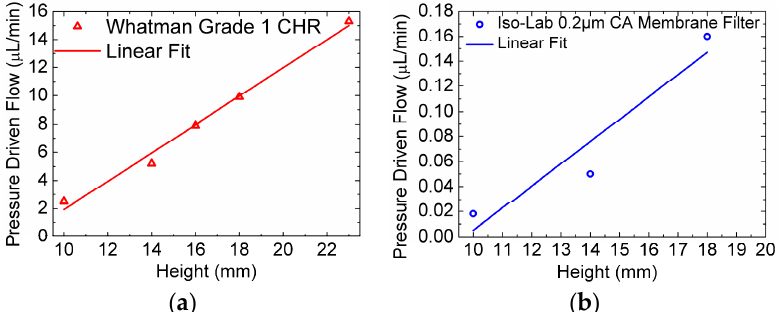
Figure 2. Pressure driven flow results of the Whatman Grade 1 CHR filter paper ( a ) and 0.2 μ m cellulose acetate (CA) membrane filter ( b ) as the applied water height changes.